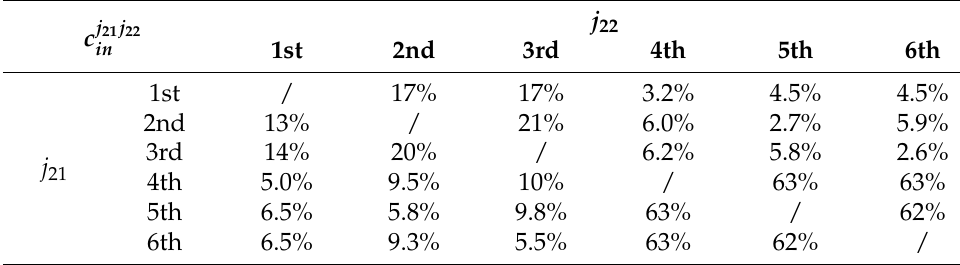
Table 4. Input coupling ratio of the 6-RRRR CPM using the